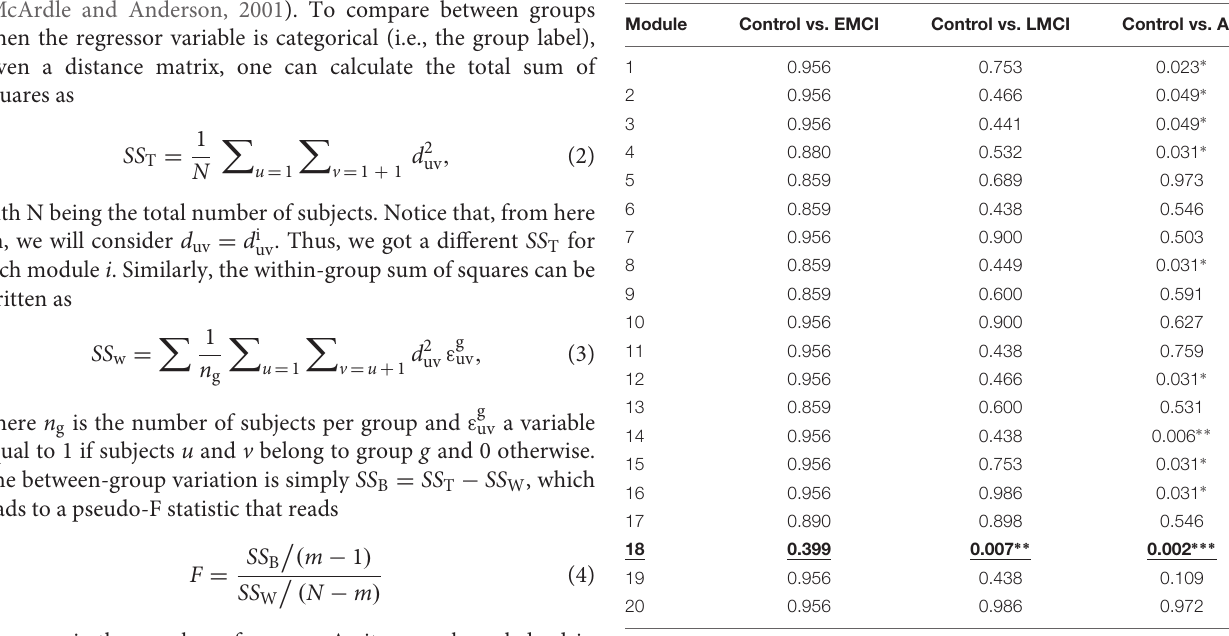
TABLE 3 | p -values associated to each module from the brain hierarchical